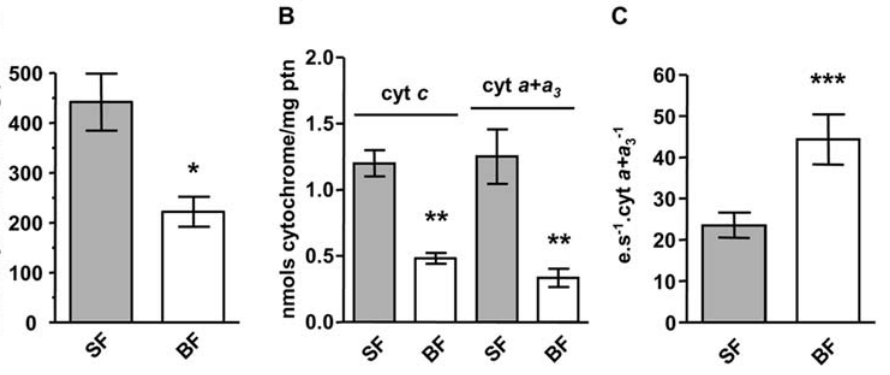
Figure 1. Blood feeding reduces cytochrome c oxidase activity and cytochromes content in A.aegypti FM mitochondria. Comparison of cytochrome c oxidase (COX) activity, cytochrome content and electron turnover number of COX were assessed in sugar-fed (SF, grey bars) and 24 h ABM (BF, white bars) A. aegypti FM mitochondria. (A) COX activity was measured as the KCN-sensitive rate of ferrocytochrome c oxidation at 550 nm in freeze-thawed mitochondria preparations (SF, n=21 vs. BF, n=10; * p =0.0157). (B) Quantification of cytochromes c (cyt c ) and a + a 3 (cyt a + a 3 ) in fresh mitochondrial preparations (cyt c : SF, n=2 vs. BF, n=3; ** p , 0.01; cyt a + a 3 : SF, n=2 vs. BF, n=3; ** p , 0.01). (C) Electron turnover number of cytochrome c oxidase was obtained in freeze-thawed mitochondria preparations (SF, n=21 vs. BF, n=10; *** p =0.0017). Bars represent mean 6 SEM. Statistical analysis was performed using Student’s t-test.